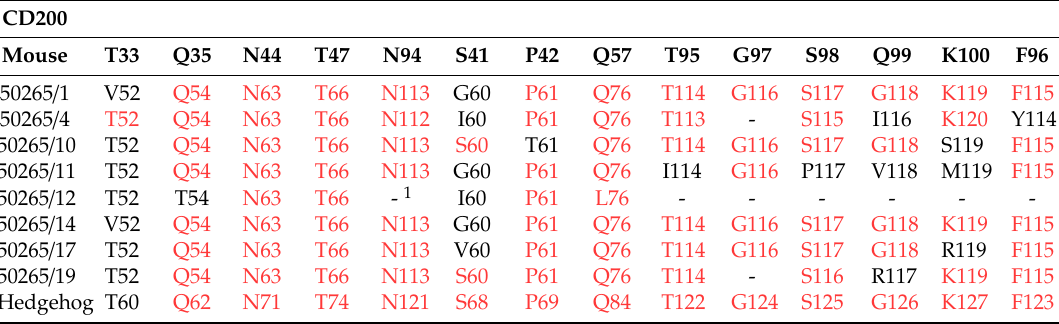
Table 2. Multiple sequence alignment showing variations in the key binding amino acid residues in CD200 / CD200R binding site. Conserved residues are highlighted in